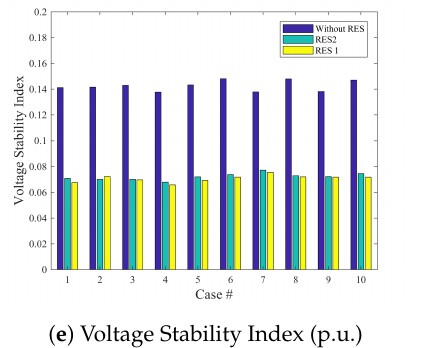
Figure 16. Overall comparisons for real power loss, total cost, total emission, voltage deviation, and